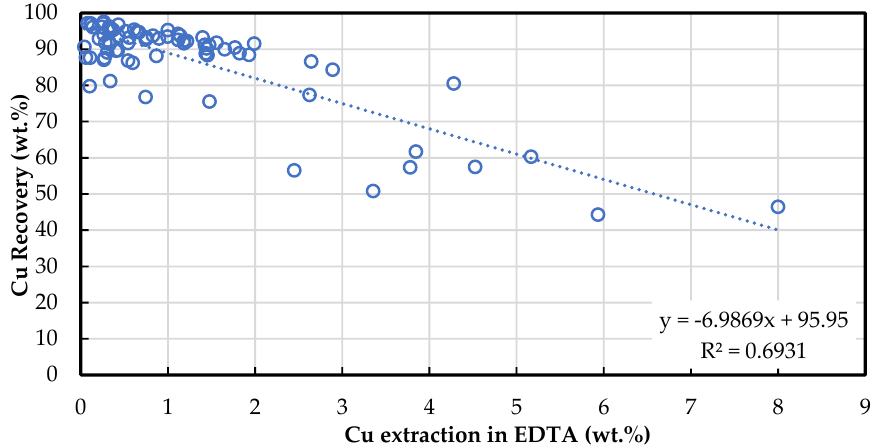
Figure 15. Copper recovery versus Cu extraction in EDTA for both bulk and size-by-size samples, except for those with copper grades below 0.2%.